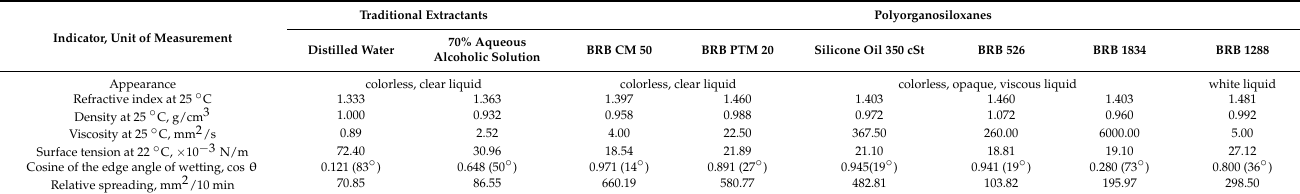
Table 2. Physico-chemical parameters of traditional extractants and investigated polyorganosiloxanes.